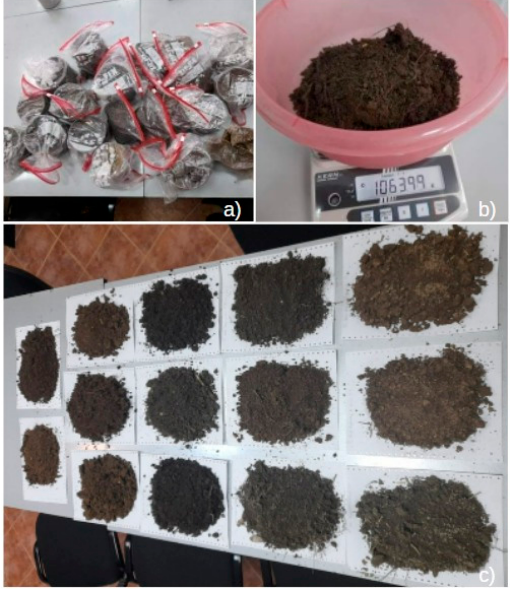
Figure 3. Dry soil measurement: ( a )—soil sample; ( b )—weight measurement; ( c )—dry sample.